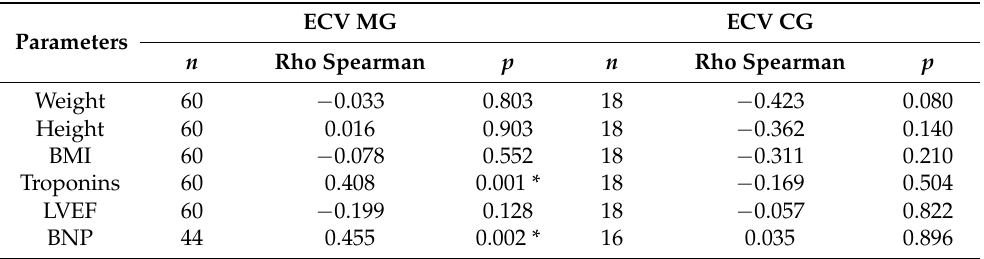
Table 3. Spearman correlation statistics between mean ECV of each group and other parameters.